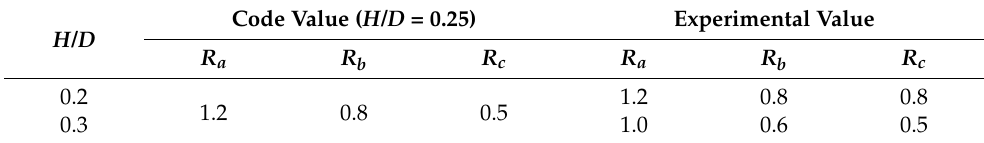
Table 10. Comparison of code value according to code area and C pn,max of open ratio = 50% [22]. Code Value ( H / D = H / D